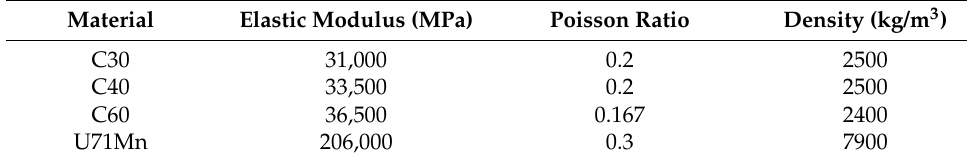
Table 3. Tunnel material parameters.